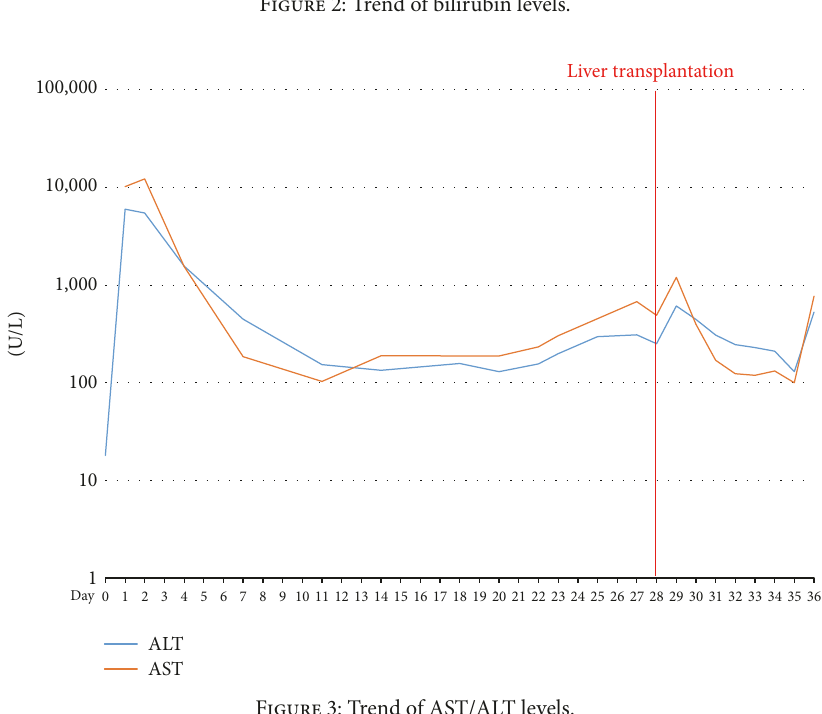
Figure 3: Trend of AST/ALT